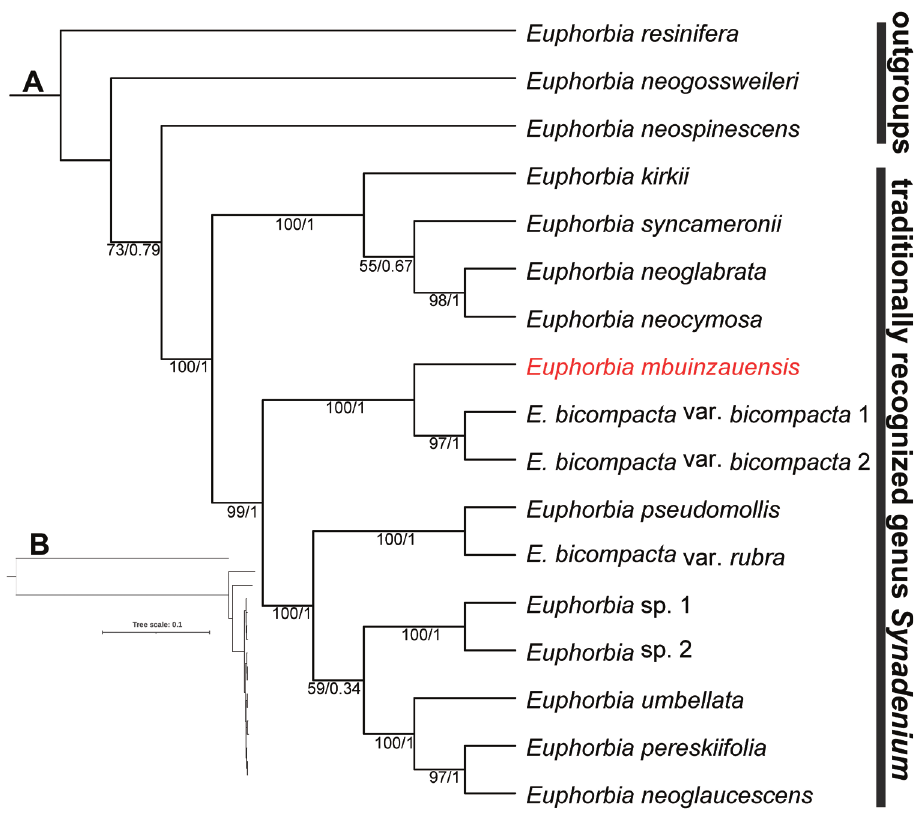
Figure 1. A The maximum likelihood tree inferred from the complete nuclear ribosomal DNA sequenc- es to elucidate the phylogenetic position of Euphorbia mbuinzauensis . Bootstrap and Bayesian posterior probability values are shown below the branches (BS/PP). The new species is highlighted in red B same tree as A showing branch lengths proportional to nucleotide substitutions per